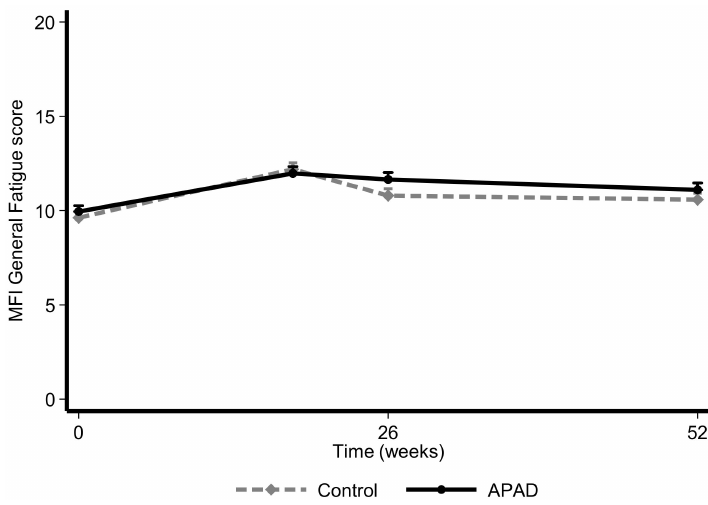
Figure 3. Evolution of the MFI General Fatigue score according to randomization arm in the intention-to-treat population. Data are presented as mean +